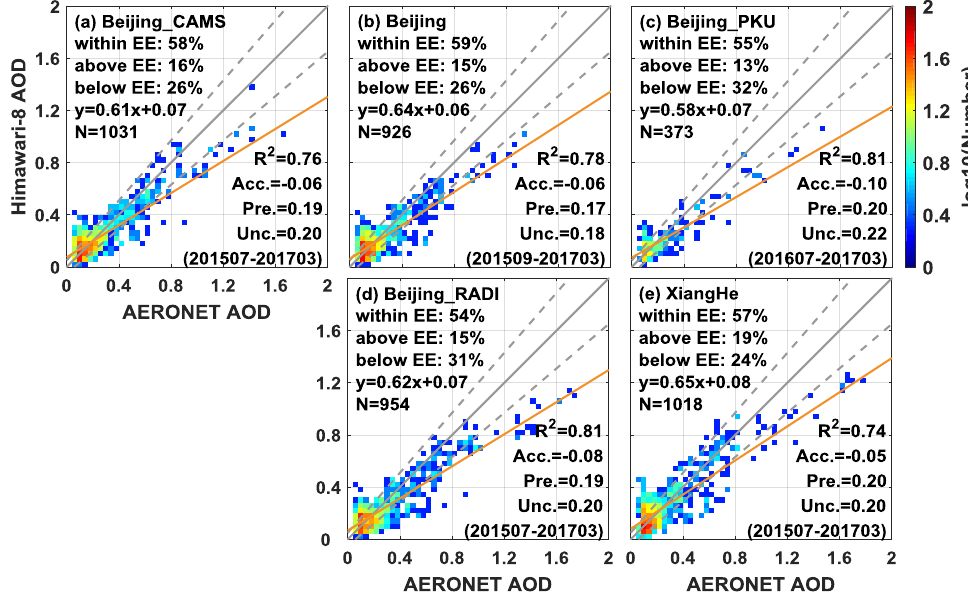
Figure 2. Collocations scatterplots of Himawari-8 and AERONET AODs at five sites of ( a ) Beijing_CAMS; ( b ) Beijing; ( c ) Beijing_PKU; ( d ) Beijing_RADI; and ( e ) Xianghe. The study period is from July 2015 to March 2017. The width of each pixel is 0.04 AOD, and the number of collocations falling within/above/below EE are represented in each figure. The yellow line is the regression line, the gray solid line is the 1:1 line, and the gray dashed lines are the expected errors (EE) envelopes.